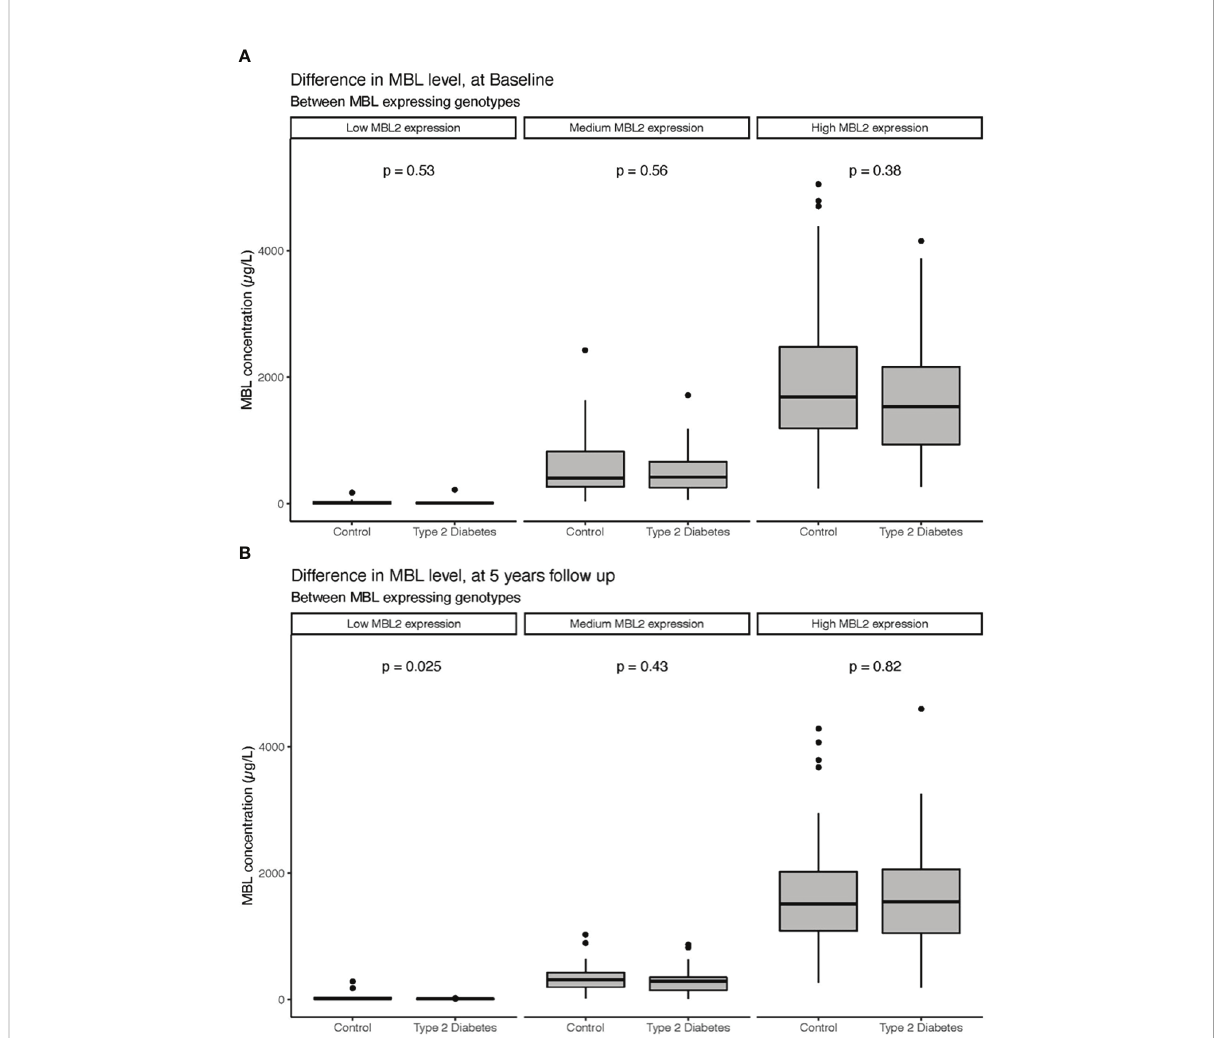
FIGURE 1 Serum levels of MBL at study entry (A) and 5-year follow-up (B) in patients with T2D and healthy controls divided according to MBL expressing genotypes. Bars represent medians, and boxes indicate IQRs. P-values are calculated with the Mann-Whitney U-test for differences between